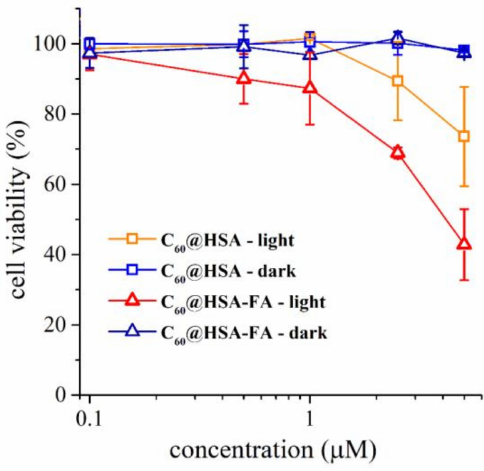
Figure 7. Phototoxicity of C 60 @HSA and C 60 @HSA-FA in the 0.1–5 µ M range. Percentage of cell viability for irradiated and not irradiated HeLa cells incubated with C 60 @HSA and C 60 @HSA-FA. C 60 @HSA: irradiated, orange squares; not irradiated, electric blue squares. C 60 @HSA-FA: irradiated, red triangles; not irradiated, dark blue triangles. Each value represents the average ± 1 standard deviation of at least 2 independent